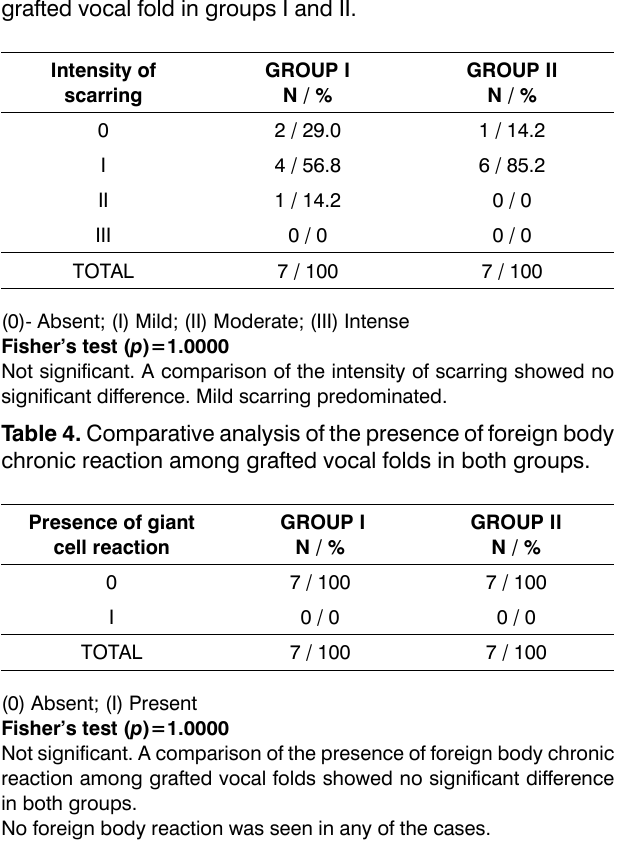
Figure 1. Masson’s trichrome. 40x - right vocal fold. Grafted right vocal fold with fascia. Note the graft in blue within the vocal muscle, in a rabbit euthanized after 60 days. There is no inflammation.